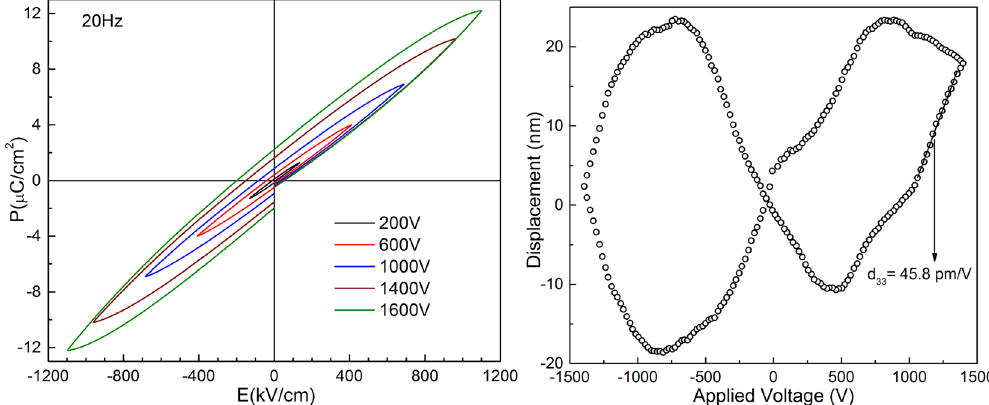
Figure 3. ( a ) Hysteresis loops of the membrane at several applied fields; ( b ) Displacement vs . applied